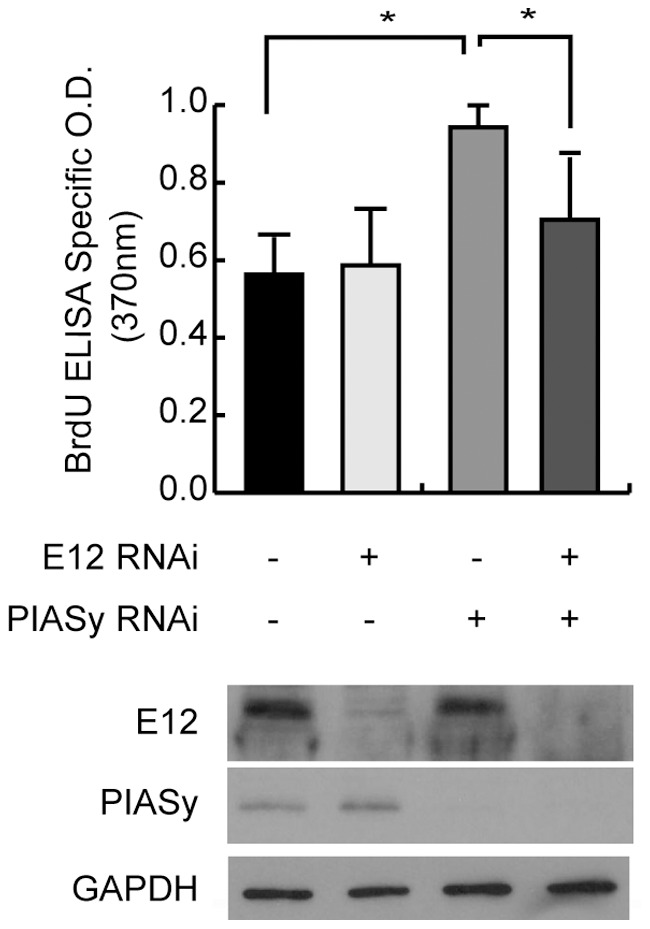
Effect of siRNA specific for PIASy and E12 in cell proliferation in MCs.siRNA specific for E12 did not affect the BrdU incorporation, but siRNA specific for PIASy obviously enhanced the cell proliferation 48 hours later after the transfection. The enhancing effect was significantly attenuated in combination with the knockdown of E12 by the RNA interference. Values were expressed as means ± SD (n = 3).